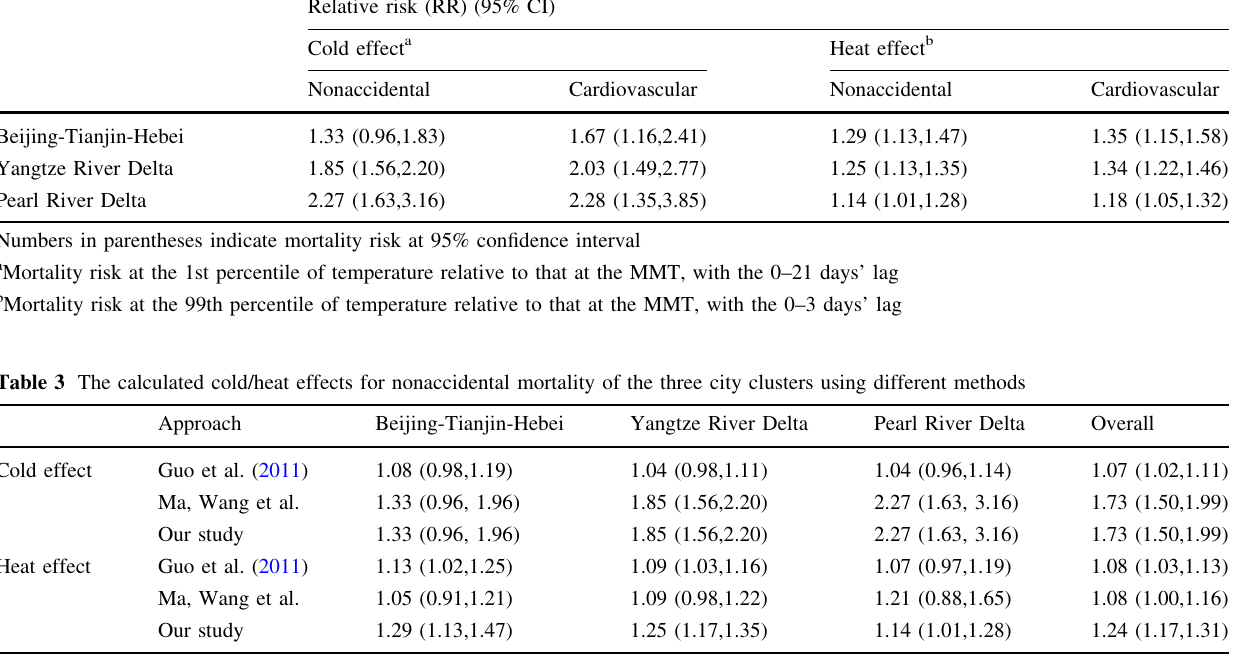
Table 2 Pooled cold and heat effects of temperature on nonaccidental mortality and CVD in the three city clusters of eastern China